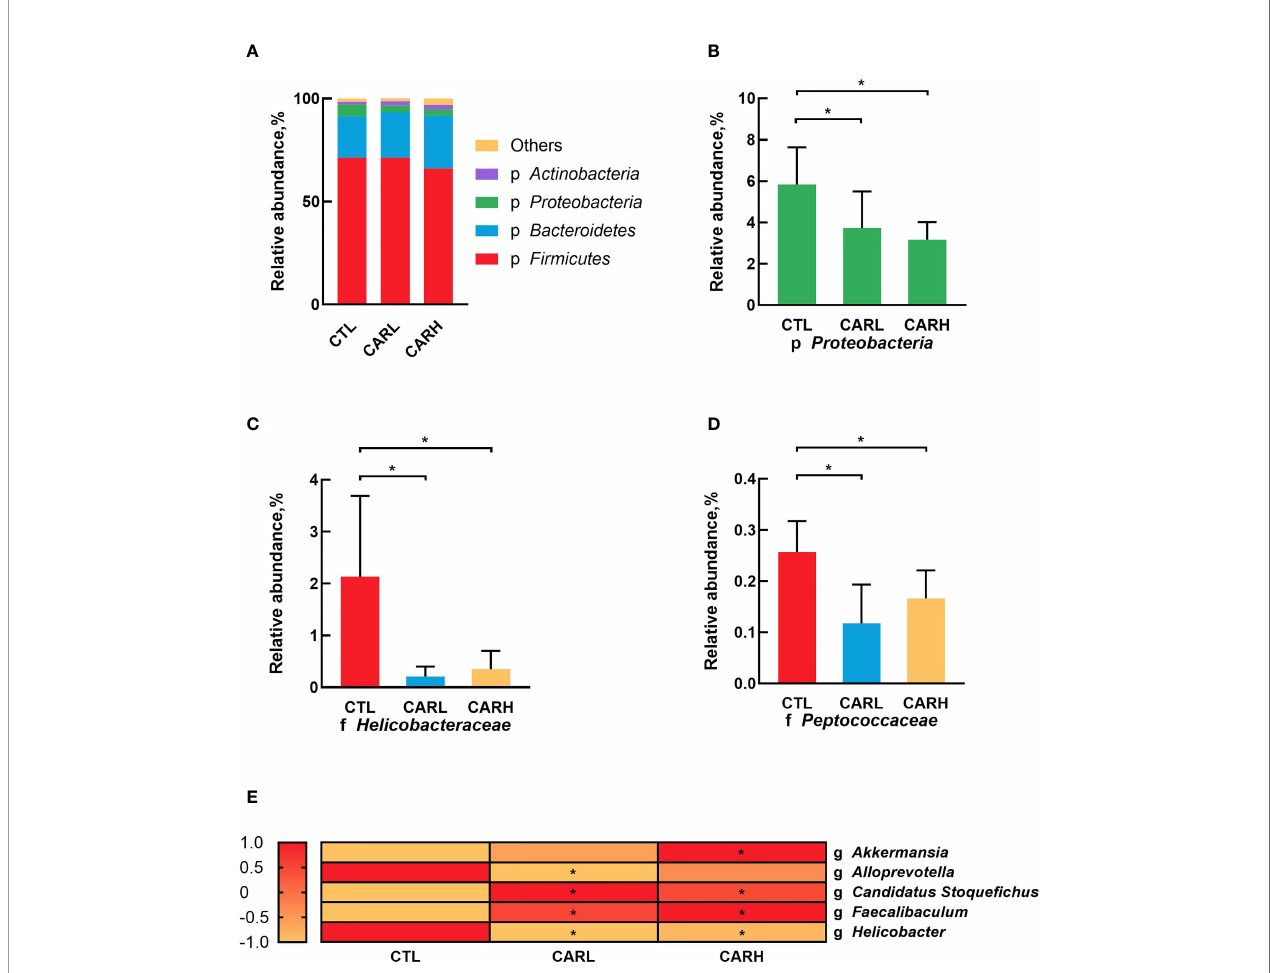
FIGURE 4 | Modulation of gut microbiota by b -carotene. Effect of b -carotene on the relative abundance of main microbes at the phylum level (A) , proteobacteria phylum (B) , Helicobacteraceae family (C) and Peptococcaceae family (D) , and main microbial genera (E) were analyzed by 16S rRNA gene sequencing. CTL, a basal diet; CARL, a basal diet containing 30 mg/kg b -carotene; CARH, a basal diet containing 90 mg/kg b -carotene. Data were shown as means ± SD (n = 6). * P <